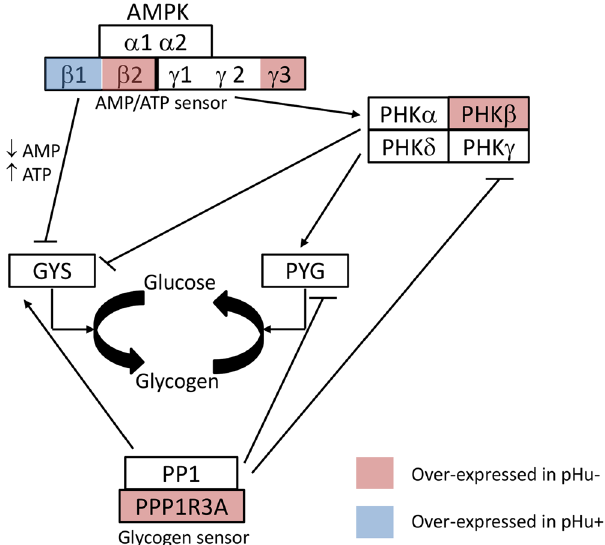
Figure 6. Molecular actors of glycogen turnover. Function of the studied enzymes in the regulation of muscle glycogen metabolism. AMPK = adenosine monophosphate-activated protein kinase; PHK = phosphorylase kinase; GYS = glycogen synthase; PYG = glycogen phosphorylase; PP1 = protein phosphatase-1; PPP1R3A = protein phosphatase-1 regulatory subunit